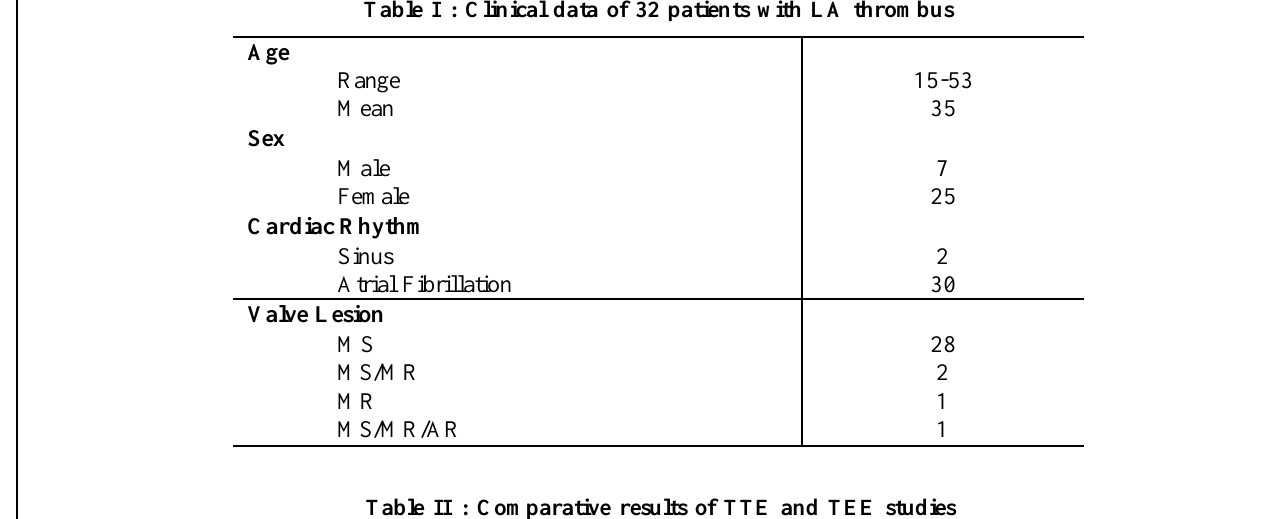
Table I : Clinical data of 32 patients with LA